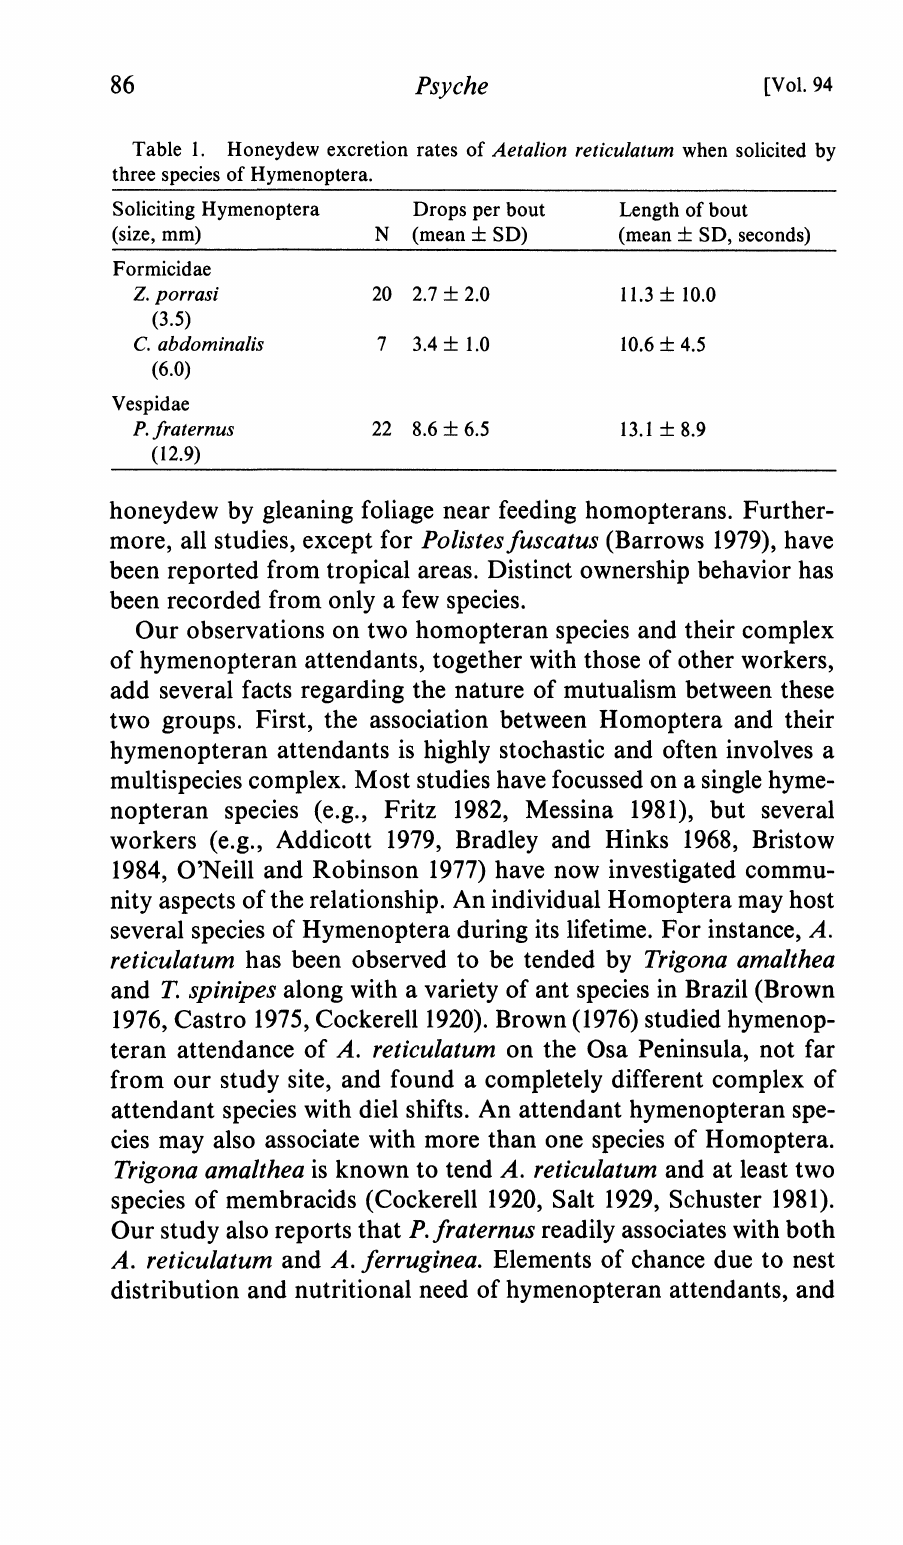
Length of bout (mean + SD, seconds)